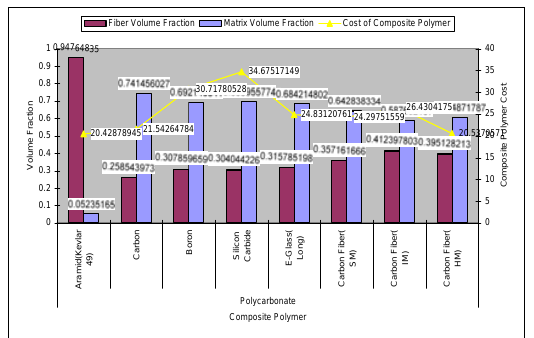
Figure 10: Shows the volume fractions of both Polymer Matrix and Reinforcement fibers and the cost of polymer composites: polycarbonate with different reinforcement fibers.